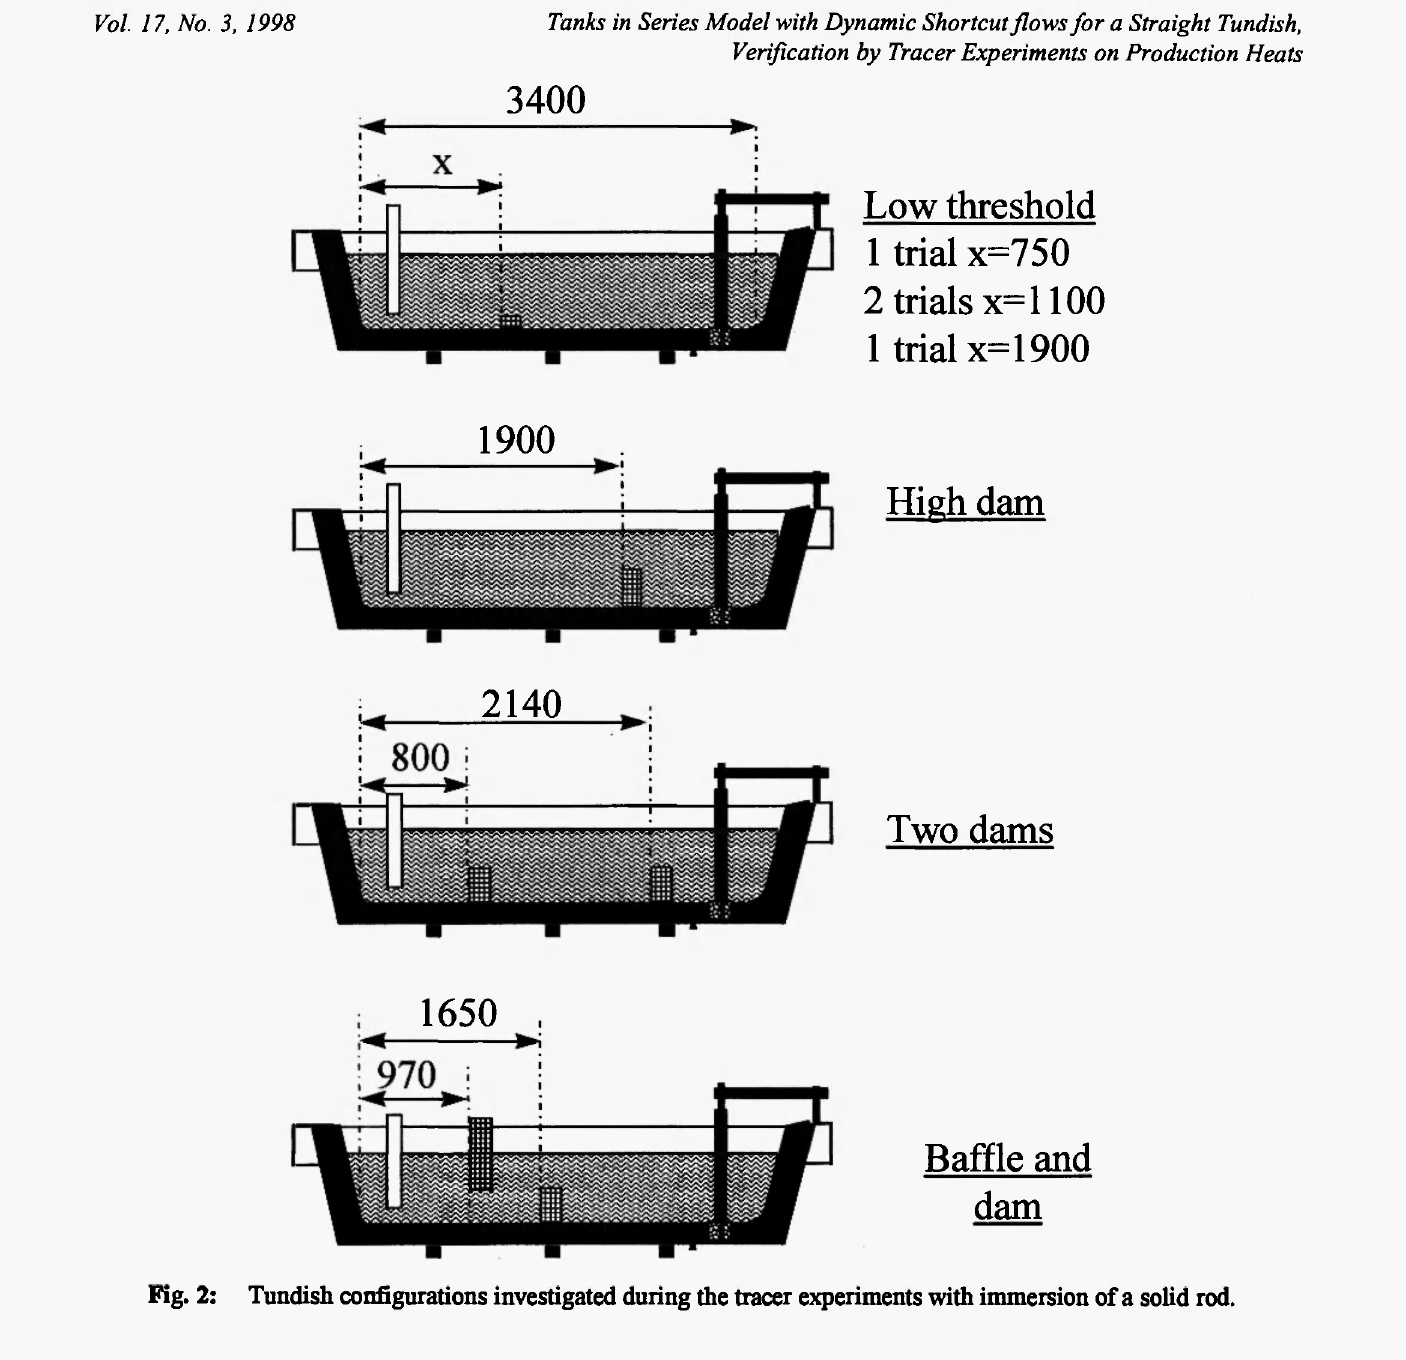
the sequence was adjusted by the addition of 10 to 20 kg of Ni during the ladle treatment. The addition was chosen to give a clearly detectable difference between the Ni content of that ladle and the one before and after. This made it possible to follow the mixing between the ladles as a step response in the Ni content of the steel leaving the tundish. Each experiment gave two step responses, one upward between ladle one and two and the other downward between ladle two and three.